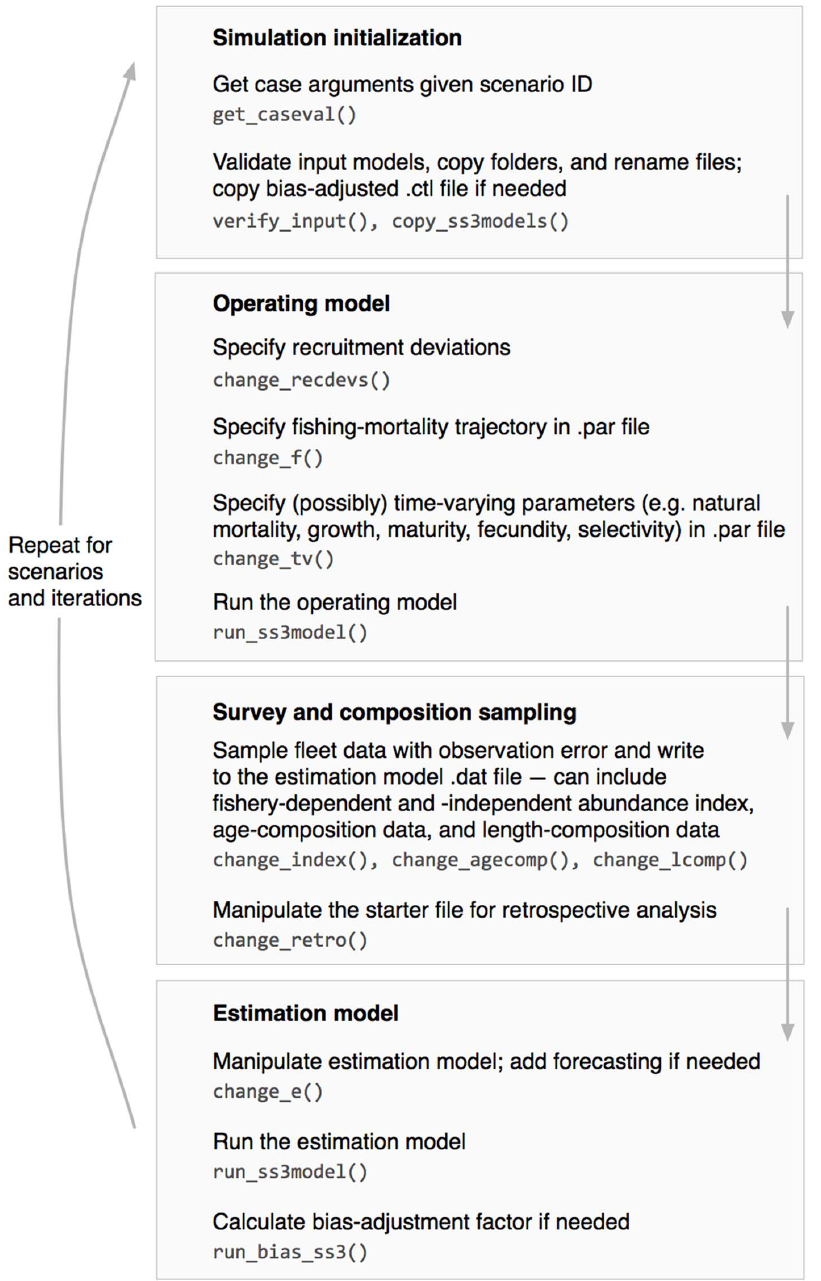
Figure 1. Flow diagram of the main steps in an ss3sim simulation carried out using run_ss3sim. Functions that are called internally are shown in a monospaced